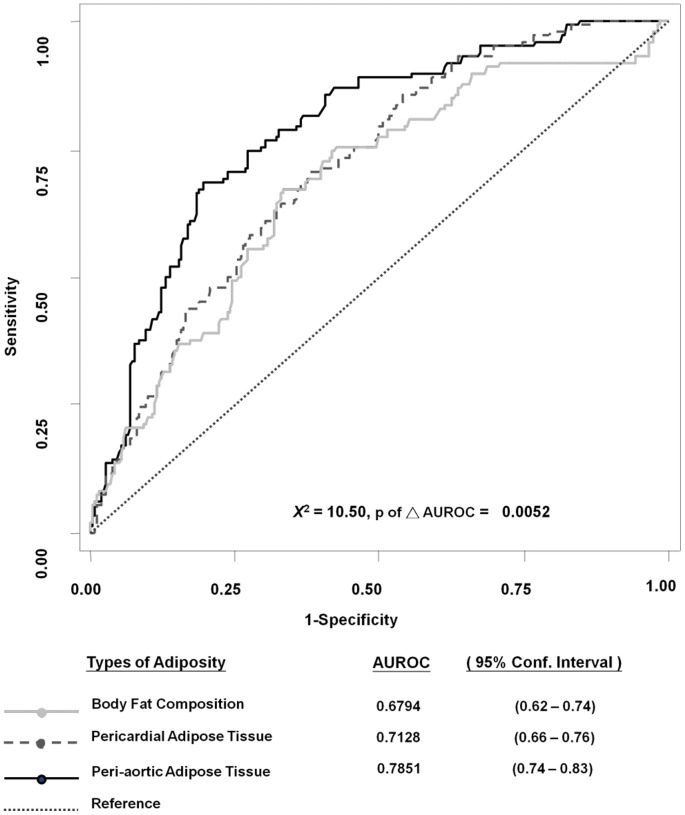
Receiver operating characteristic (ROC) curves for each measure of adiposity in identifying metabolic syndrome, with individual 95% confidence interval (95% CI) reported. Furthermore, the difference between each area under ROC (AUROC) was calculated with p value provided for statistical significance (p of ΔAUROC). The area under the ROC curve (AUROC) was largest for peri-aortic adipose tissue (p of ΔAUROC: 0.00562).